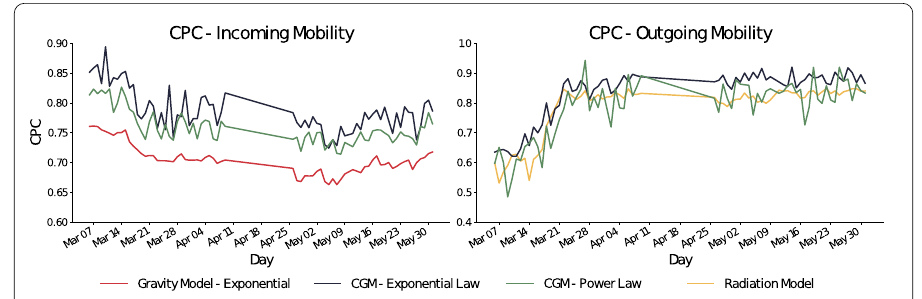
Figure 5 On the left, CPC for outgoing mobility of the gravity model with exponential decay (red) and the two versions of CGM (with exponential law in blue and with power law in green). On the right, the CPC for incoming mobility of the two CGMs and the radiation model (yellow). In both the cases, GCM outperforms the traditional gravity model and, in general, is the model with the higher average CPC